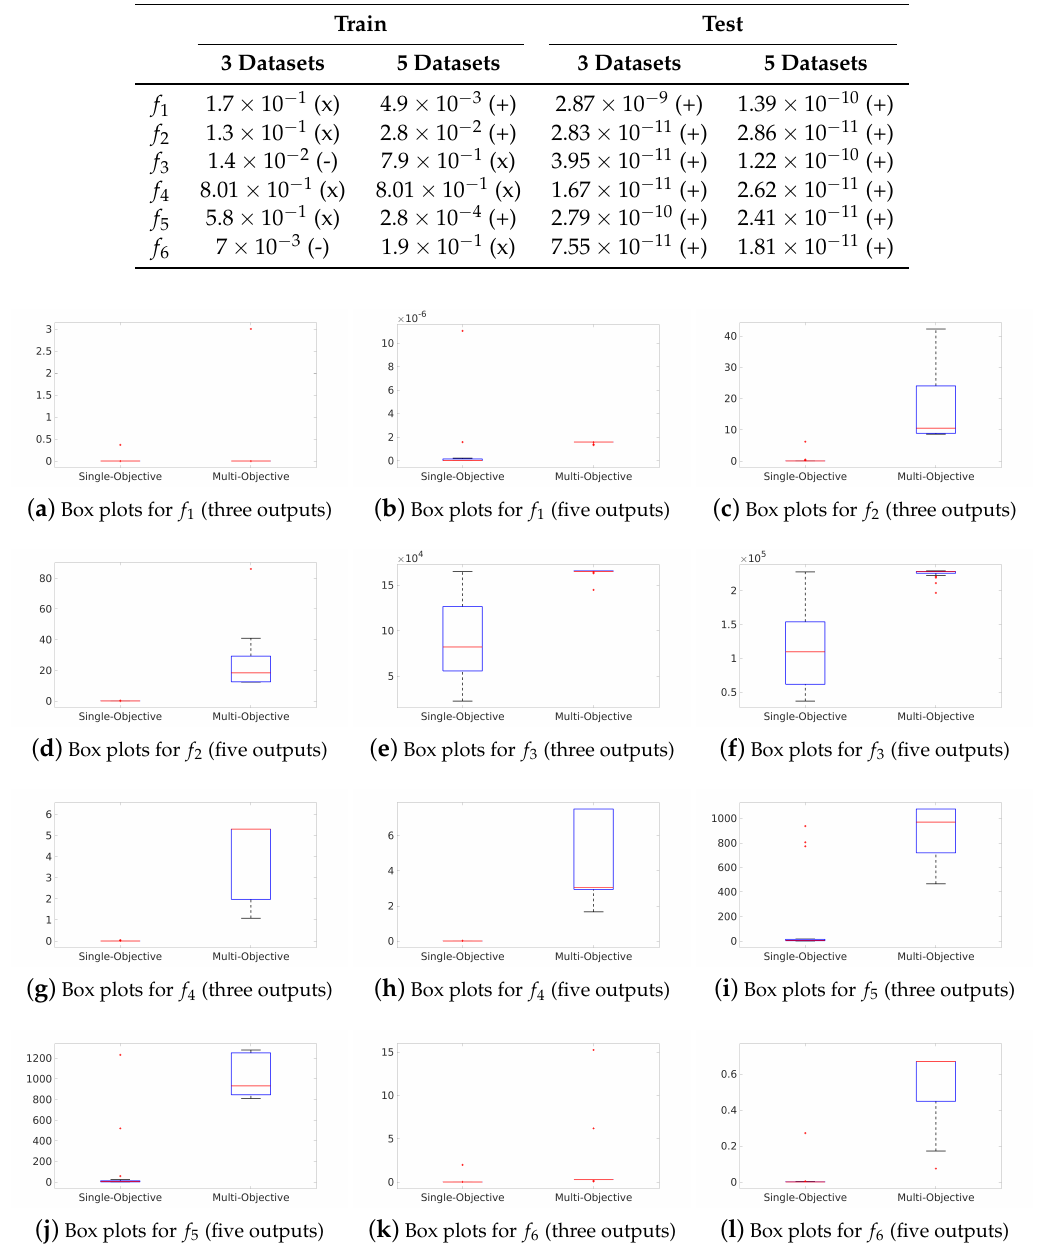
Table 2. Statistical tests to compare algorithms in the results of all benchmark algebraic expressions.